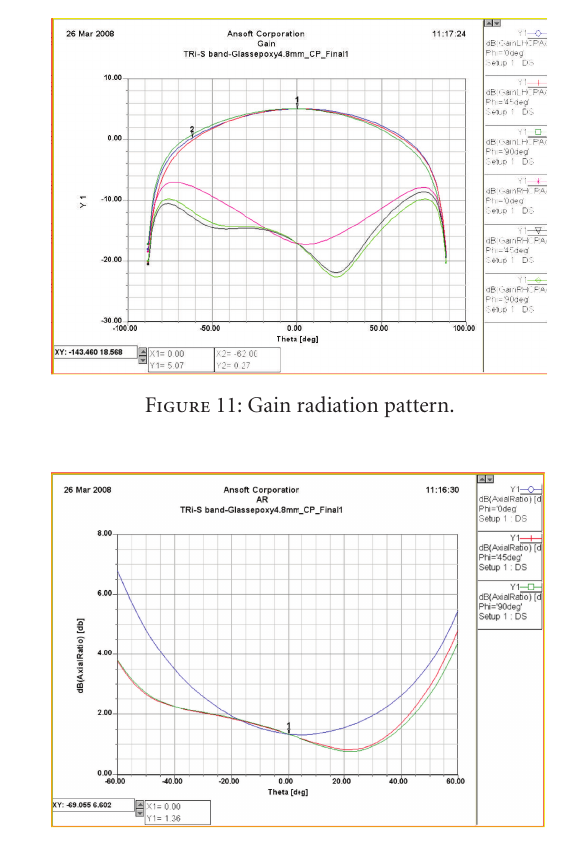
Figure 12: Axial